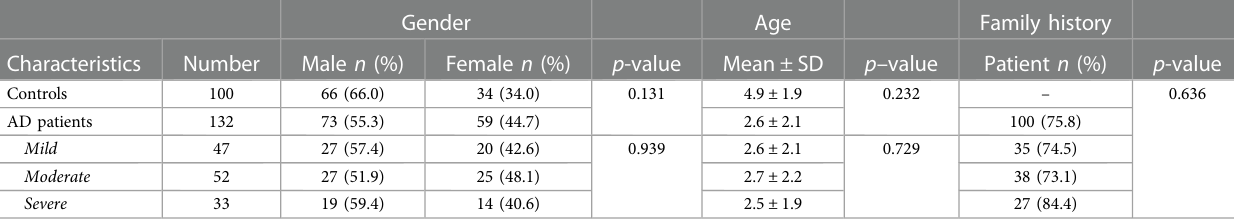
TABLE 1 Demographics and clinical characteristics of AD patients and